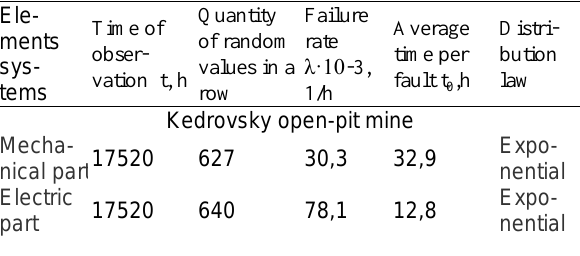
Table 1. The distribution law parameters of a time per fault of rope shovel electromechanical system